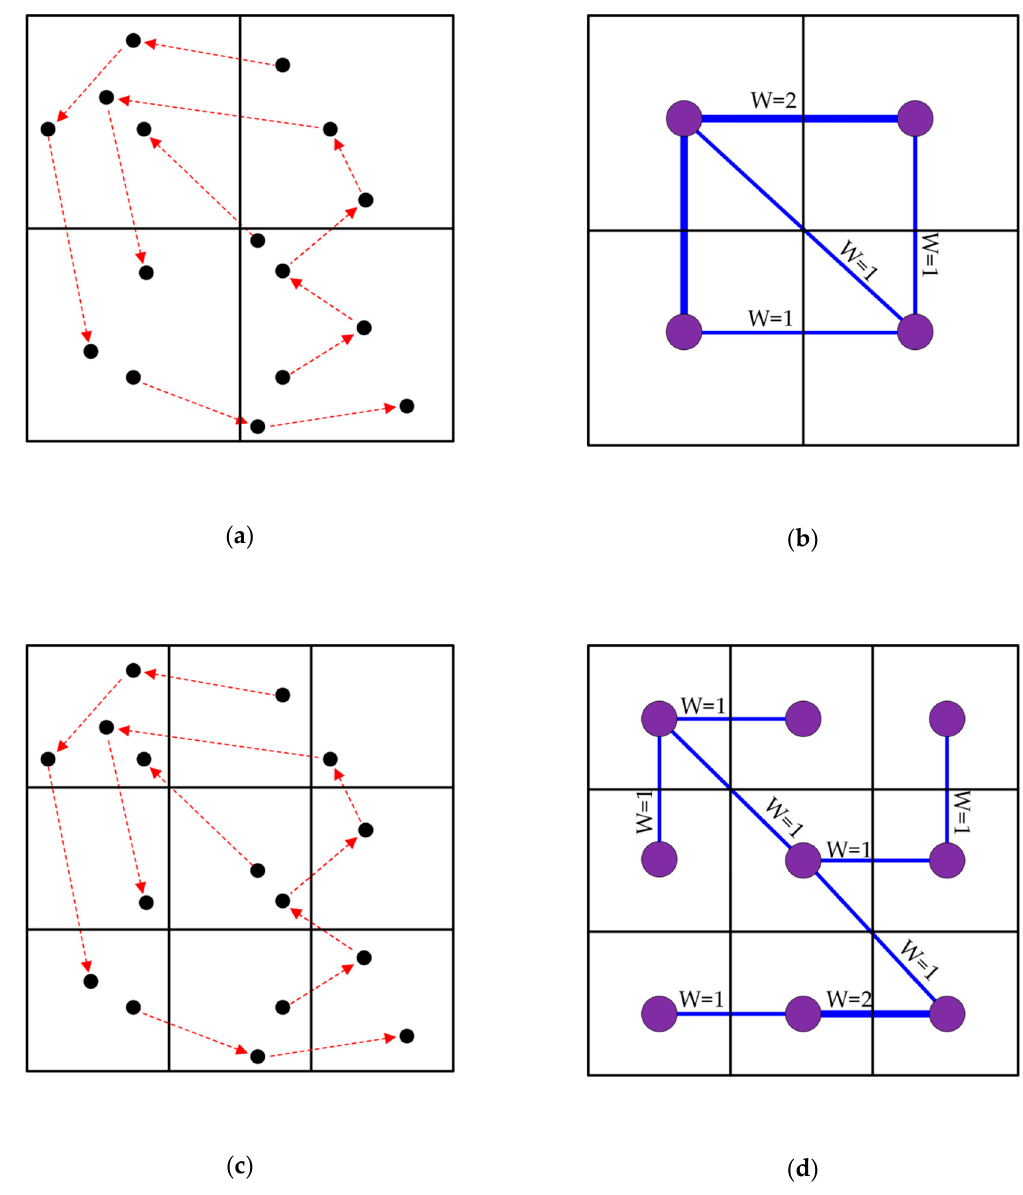
Figure 2. Variation of network with different cell sizes. ( a ) and ( c ) represent the variation of tessellation using different cell sizes, and ( b ) and ( d ) are the corresponding networks.